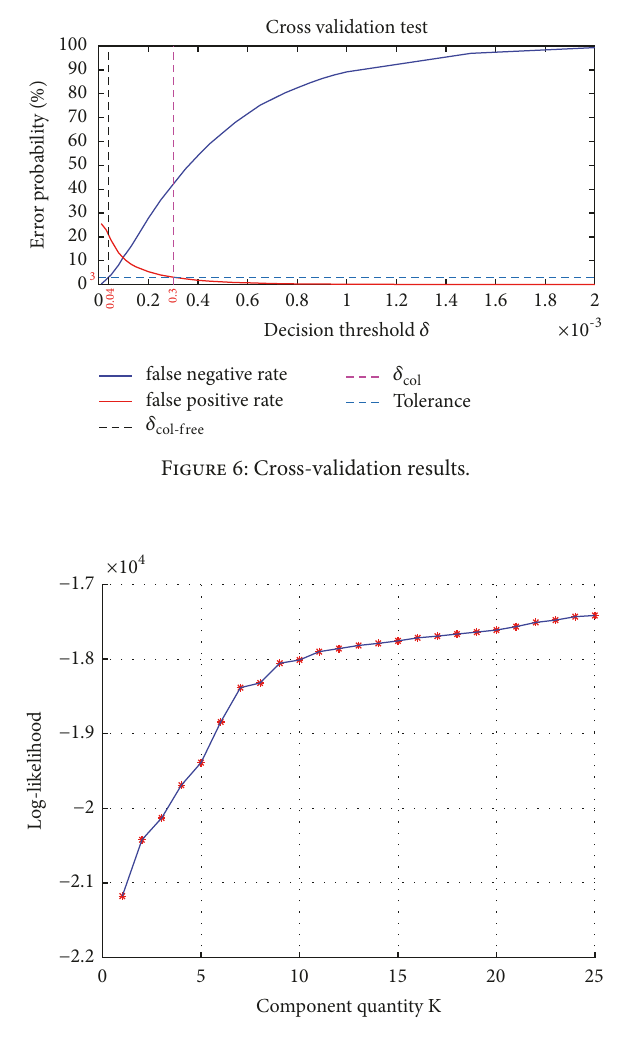
Figure 7: The learning curve of Greedy EM